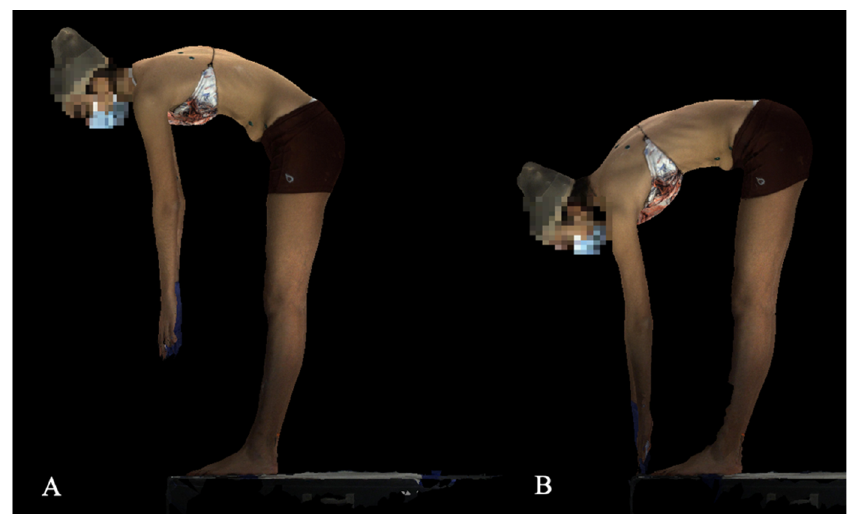
Figure 1. Finger to floor position ( A ). Subject in the Adams forward bend position. ( B ). The finger to floor scan, where the subject is reaching to the floor to his or her maximum extent. The patient is positioned on a block in the event they can reach beyond their toes.